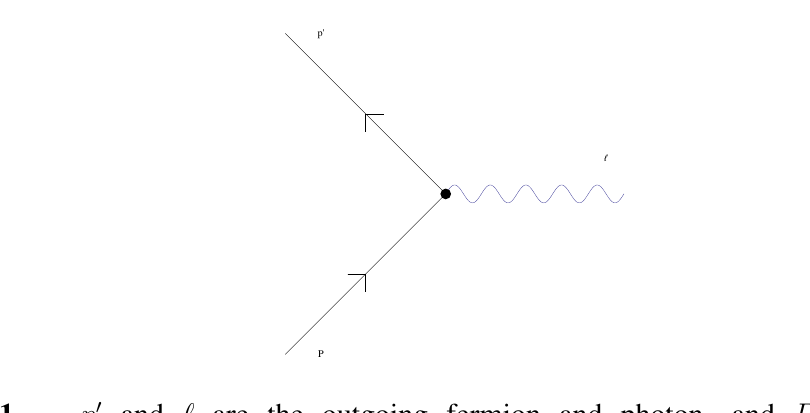
Figure 1. p (cid:48) and (cid:96) are the outgoing fermion and photon, and P indicates the incoming